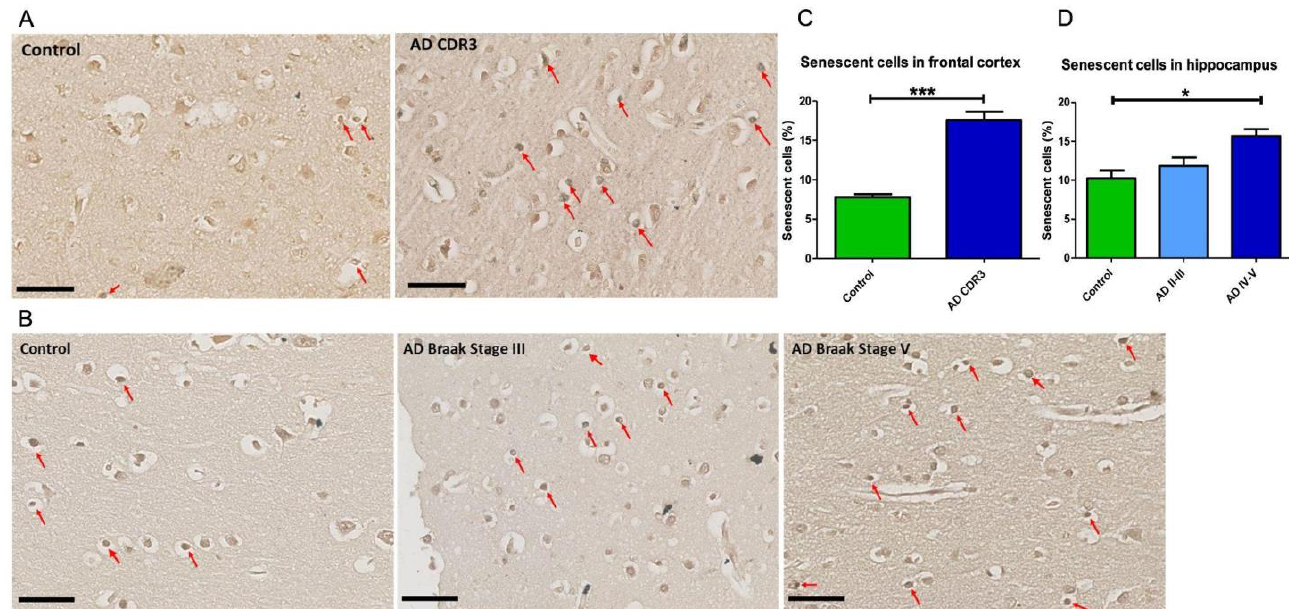
Figure 1. Senescent cells were increased in the hippocampus and frontal cortex of patients with advanced stages of AD. ( A ): Representative paraffin-embedded sections of frontal cortex of a healthy control (CDR 0, left panel ) and an advanced AD patient (CDR3, Braak Stage VI, right panel ) and ( B ) hippocampal sections of a healthy control ( left panel ), an AD Braak stage III patient ( middle panel ) and an AD patient (Braak stage V ( right panel ). Senescent cells indicated by arrows were identified with the lipofuscin reagent SenTraGor. Scale bars in ( A , B ) : 50 μm. ( C , D ): Quantification of senescent cells in the frontal cortex ( C ) of five controls (CDR 0) and six severe AD patients (CDR3, Braak Stage VI) and the hippocampus ( D ) of three controls, three AD Braak stage II/III and four AD Braak stage IV/V patients. The number of senescent cells was increased in the frontal cortex and hippocampus of AD patients at advanced stages of the disease. Statistical analysis: t-test in C and one-way ANOVA with Bonferroni correction in D. * p < 0.05; *** p < 0.005.